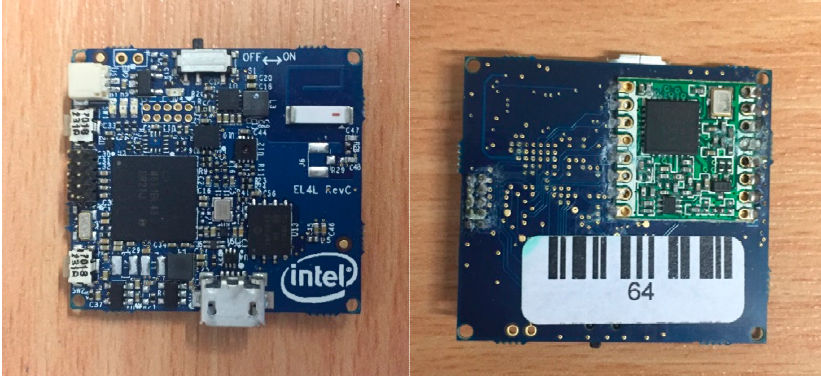
Figure 7. Custom-made device (including processor, memory, radio, inertial measurement unit (IMU), etc.).